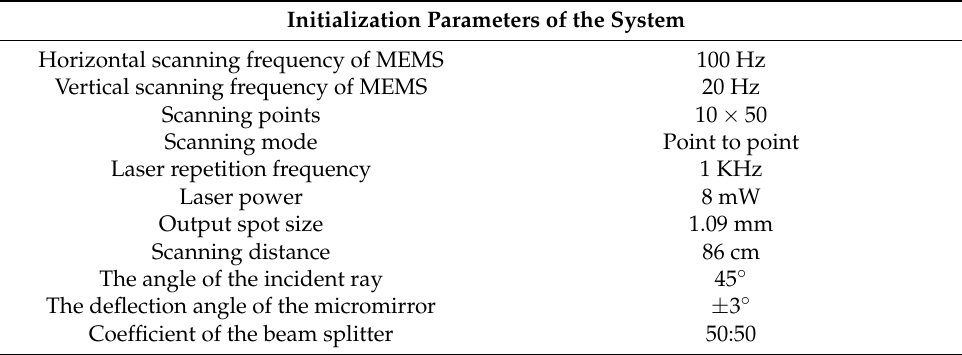
Table 1. Initialization parameter of the scanning projection system.